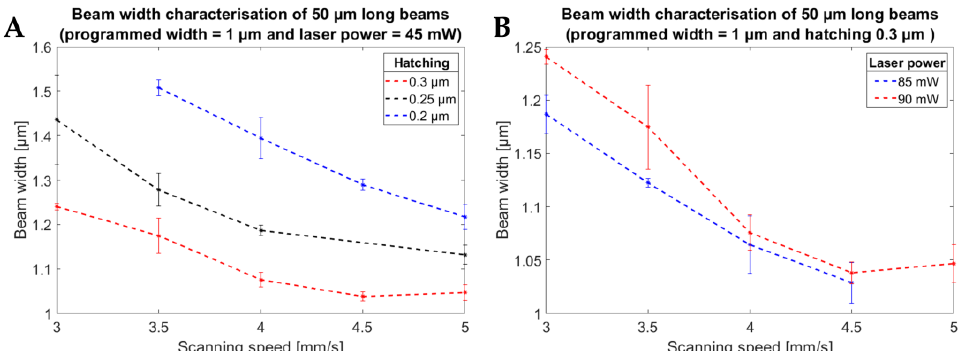
Figure 6. Plots of the measured widths of 50 µm long beams. The designed width of the beams was 1 µm. ( A ) Graph showing the effect of both the scanning speed and the hatching distance on the resulting beam widths (constant laser power at 45 mW). ( B ) Effect of the laser power on the widths of the beams at different scanning speeds (constant hatching distance of 0.3 µm).